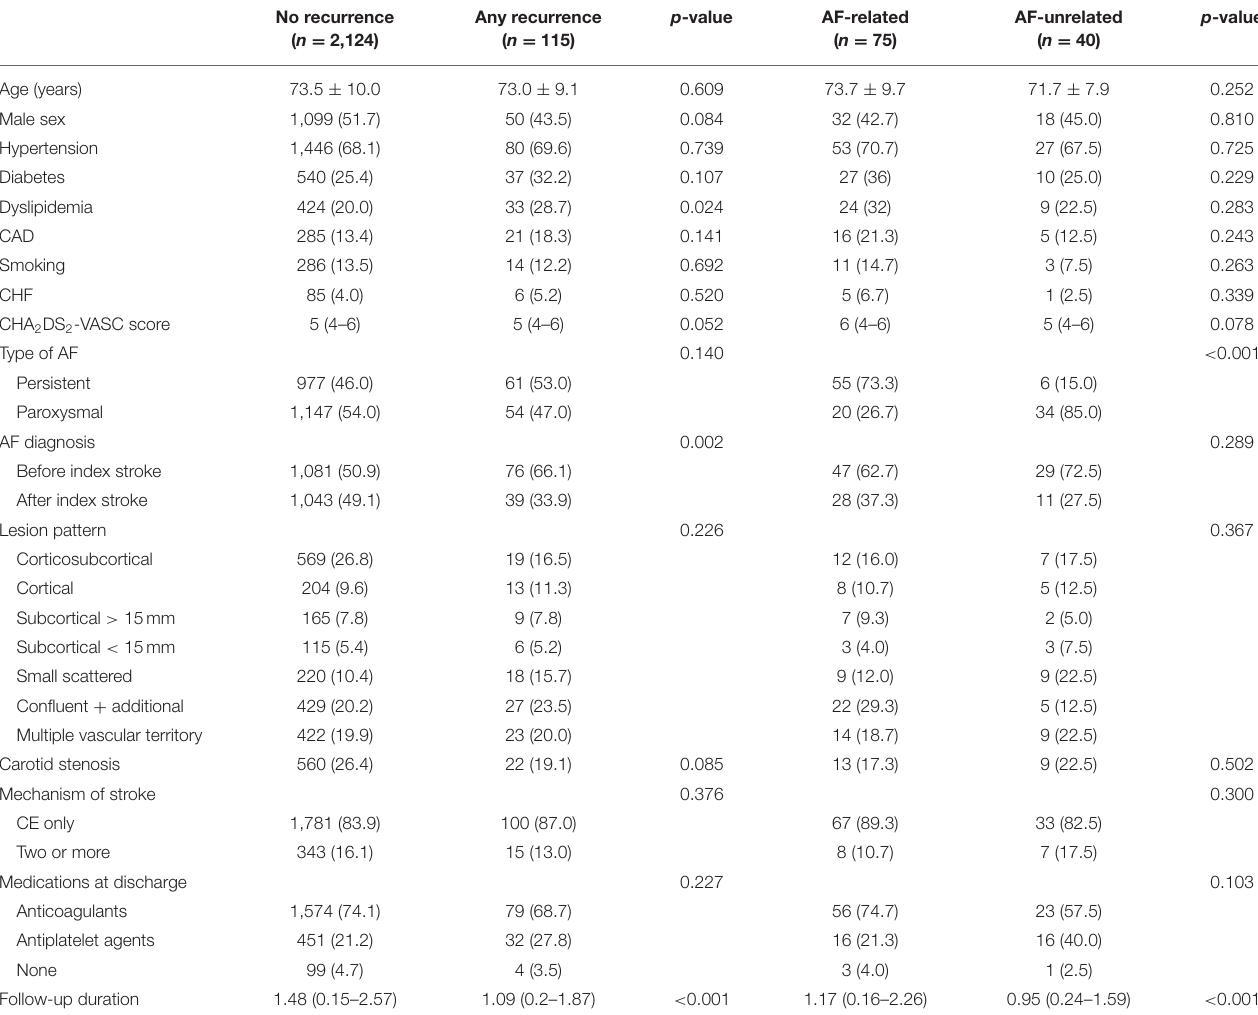
TABLE 1 | Baseline characteristics of study patients.